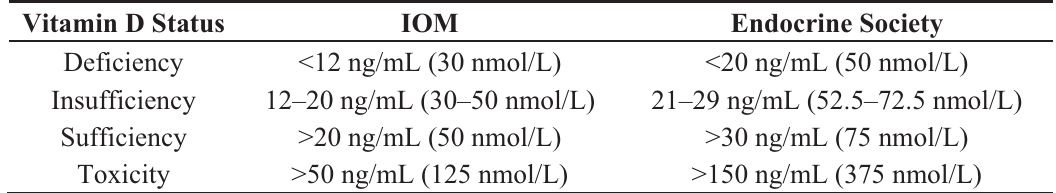
Table 1. Designation of vitamin D status based on circulating vitamin D levels by the U.S. Institute of Medicine (IOM) and the Endocrine